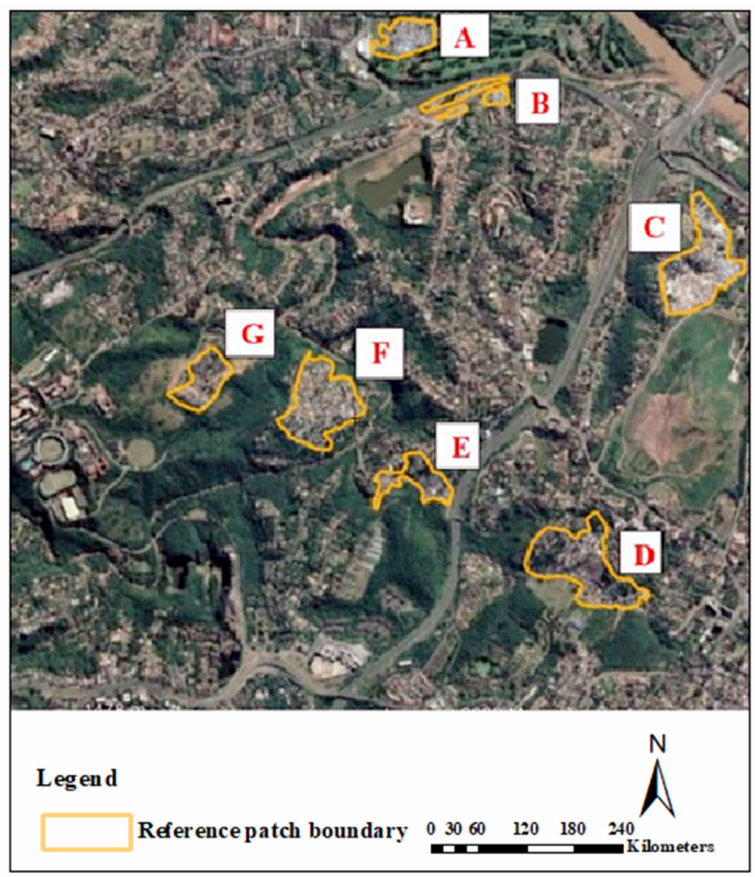
Figure 3. Ground truth samples of informal settlements (A–G